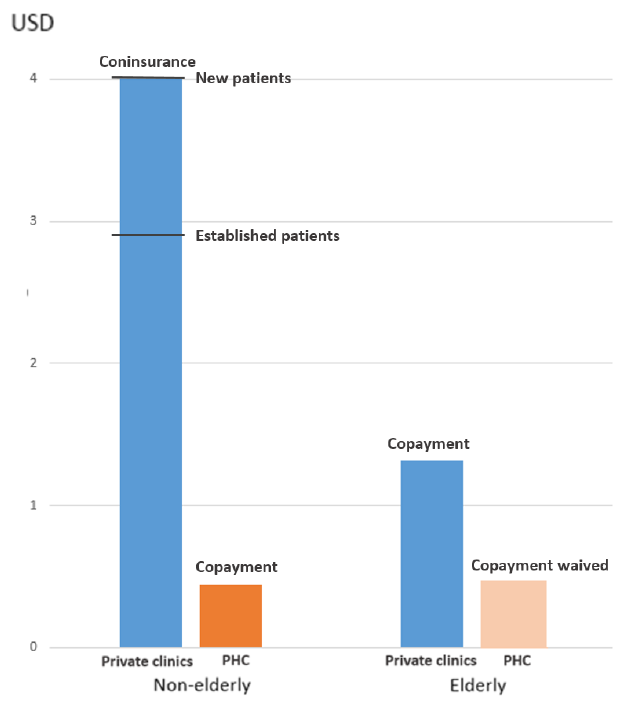
Figure A1. Out-of-pocket costs per outpatient visit in the public health clinics and private clinics.